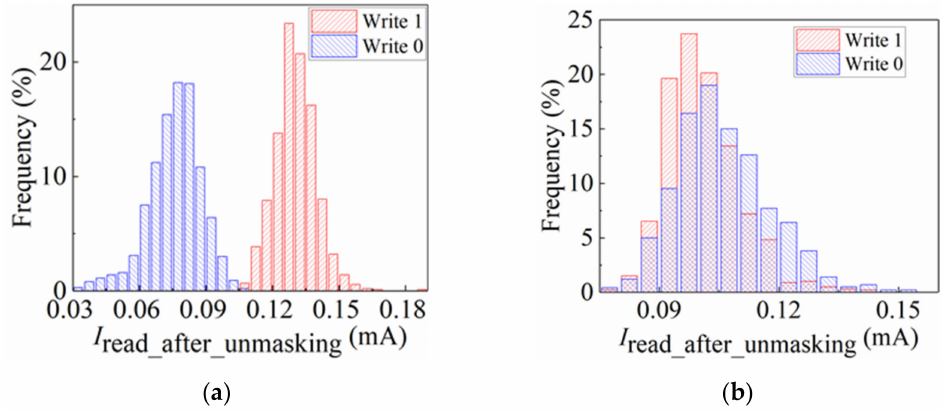
Figure 21. Quiescent current histogram for 1000 read operations (after unmasking): ( a ) cell 2; ( b ) cell